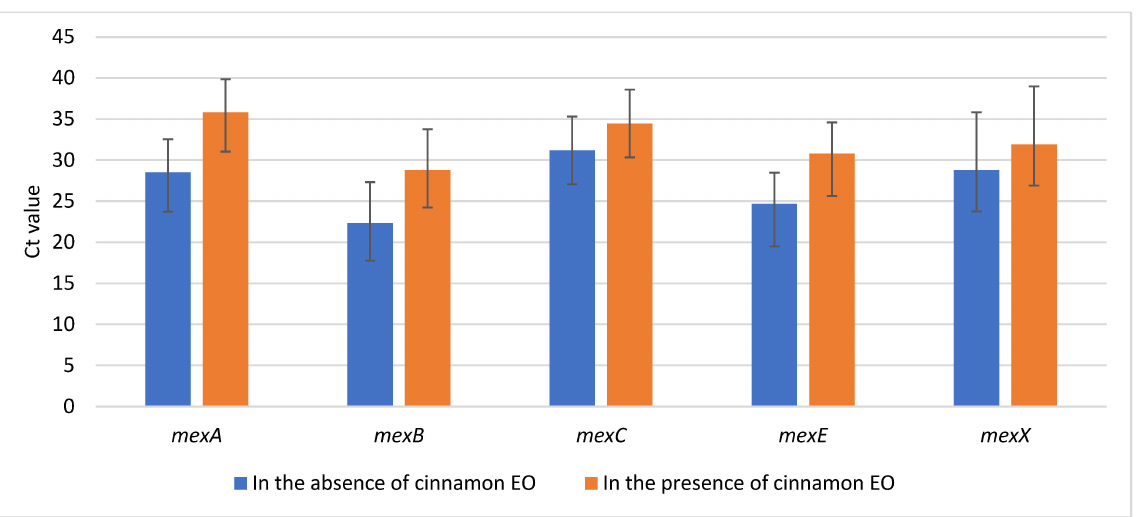
Figure 2. The comparison of average values of total RNA after extraction, with or without exposure to the cinnamon EO.